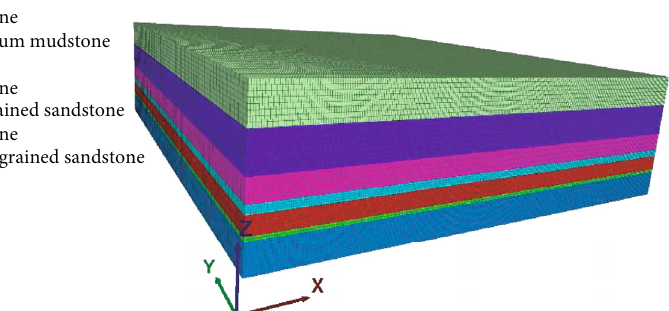
Figure 5: Numerical model diagram.